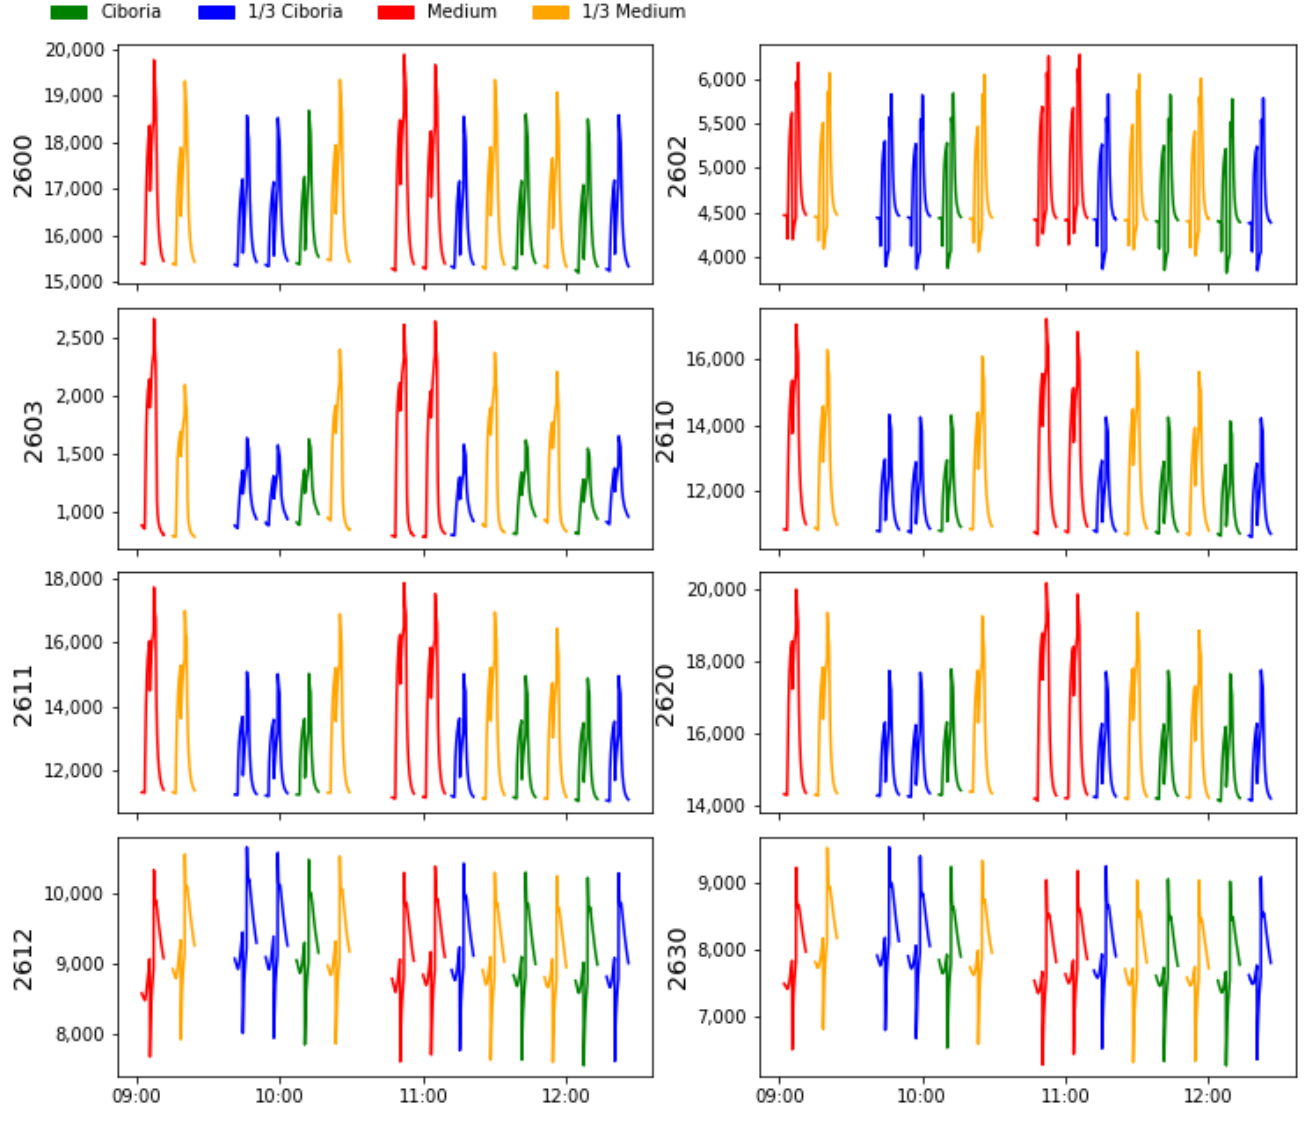
Figure A5. Raw sensor response expressed voltage measured on the resistor (output from analog– digital converter) during one day of the measurement. Hour or the measurement is presented in the x